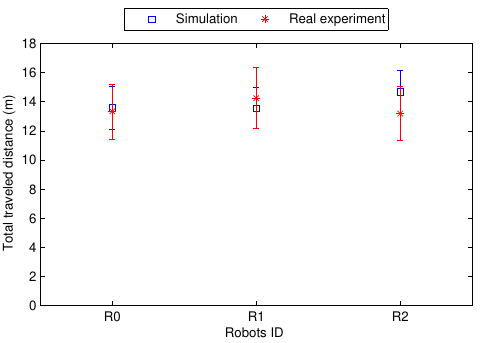
Figure 19. Average total travelled distance per robot